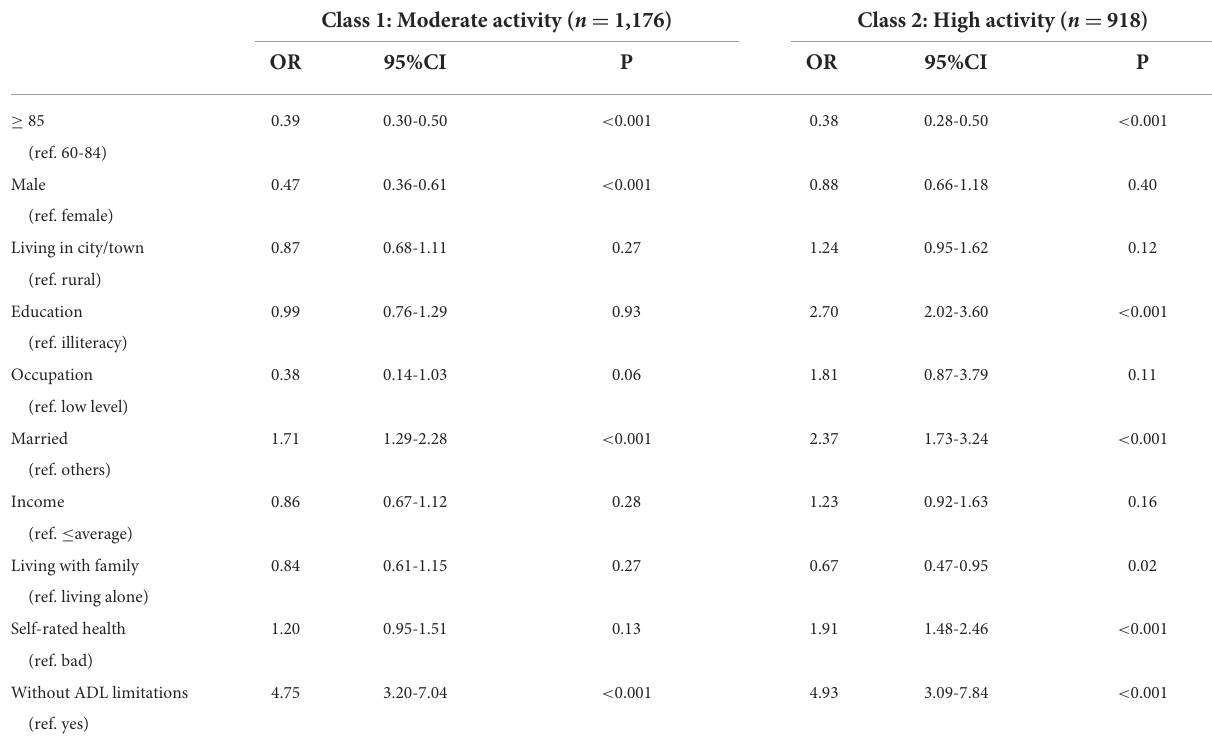
TABLE 3 Multinomial logistic regression for social participant